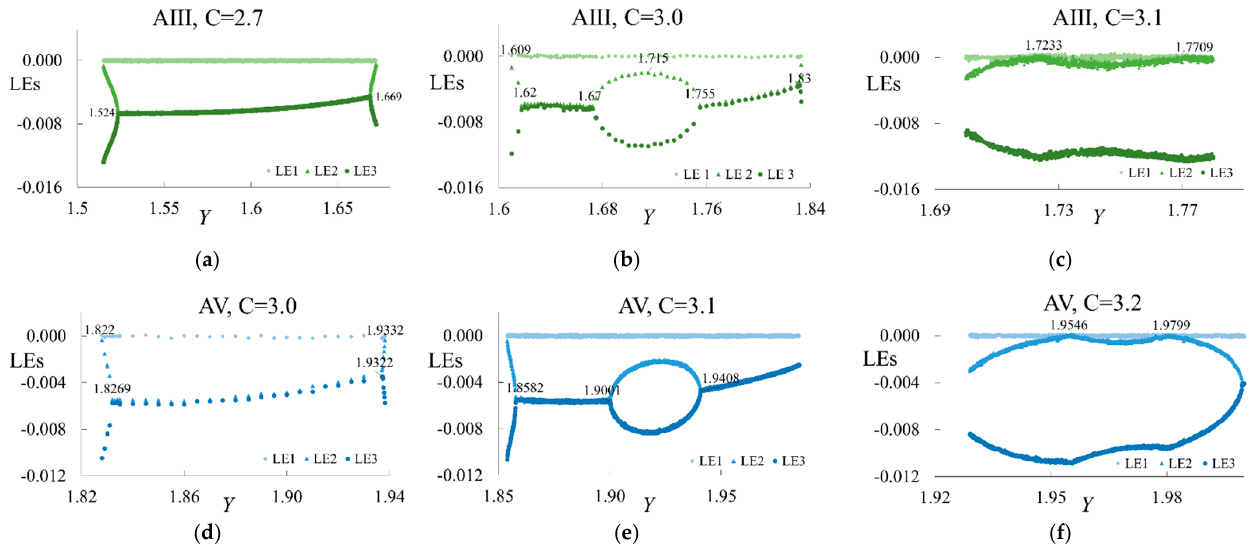
Figure 5. Schematic of LEs vs Y graphed over the partial domains of AIII and AV at different values of the gain, C . ( a – c ) AIII, the gain changes 2.7 , 3.0 , 3.1, respectively. ( d – f ) AV, the gain changes 3.0 , 3.1 , 3.2, respectively.